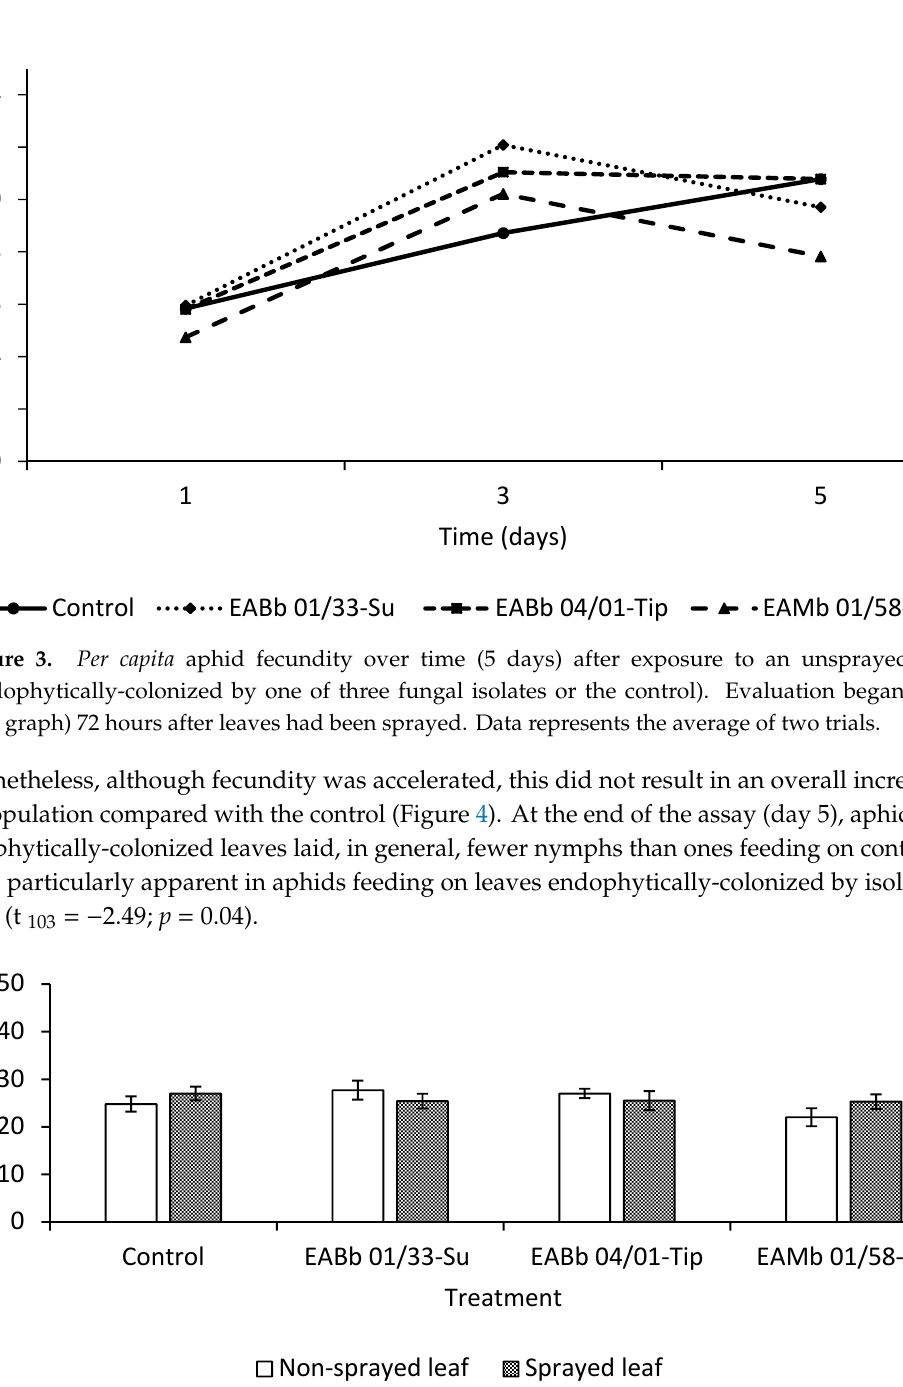
Figure 4. Total per capita aphid fecundity 5 days after applying the aphids to the plant (7 days after leaves had been sprayed). Fecundity data are pooled from the two occasions that the experiment was run.